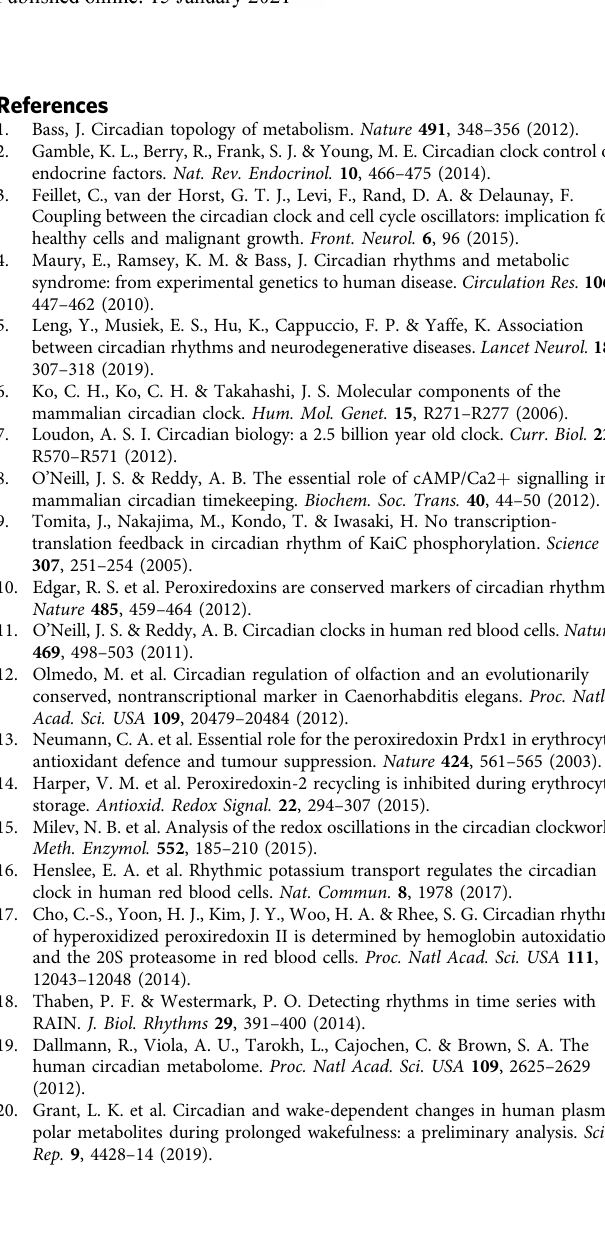
Supplementary Fig. 9. Metabolomics data for Fig. 1 can be accessed on the Metabolights platform; Study submission code: MTBLS1285 and link https://www.ebi.ac.uk/ metabolights/MTBLS1285. Source Data for fl ux experiments for Figs. 3B, C, E, F, 4A, B, 6D, E, 7B, D – F are provided in an Excel spreadsheet. The remaining data are